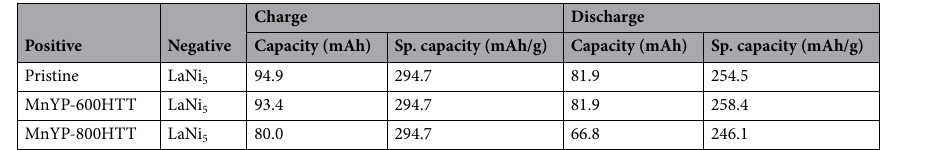
Table 2. A table for comparison between Mn-doped carbon materials for supercapacitor.